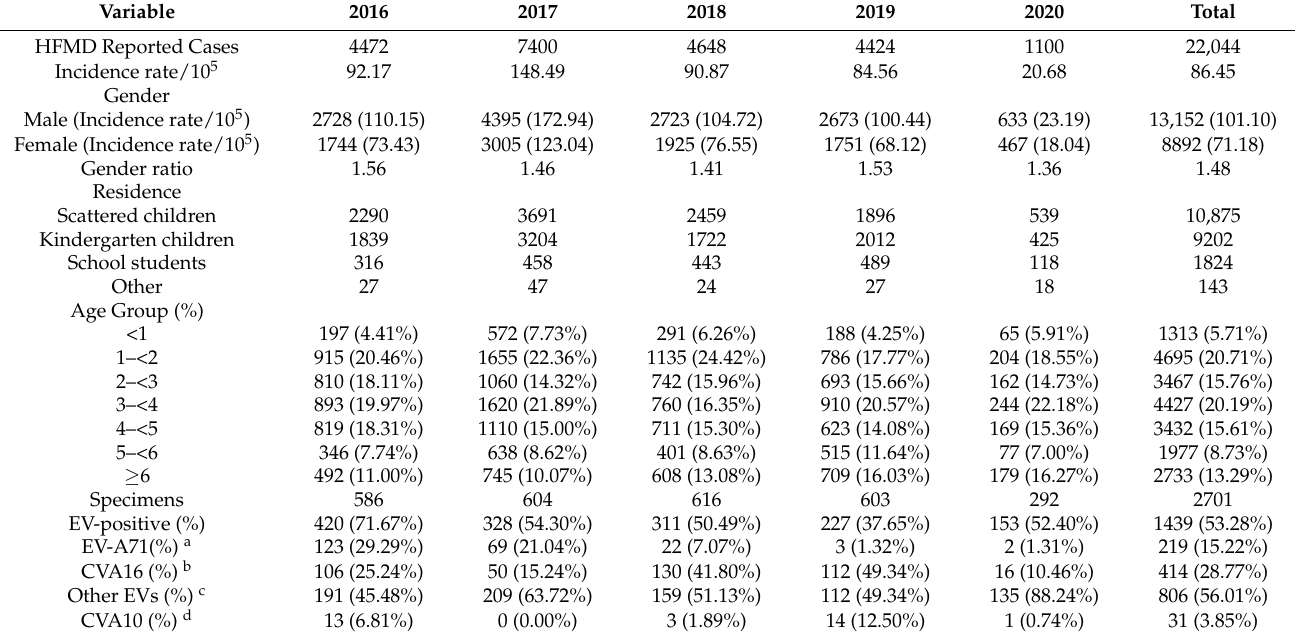
Table 1. Distribution of reported and detected HFMD cases in Taiyuan from 2016 to 2020.